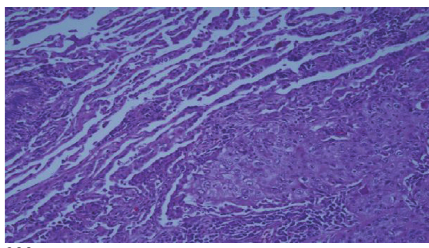
Figure 5: Normal lung tissue with intact alveolar spaces adjacent to the keratinizing squamous cell carcinoma, which, here, is more moderately differentiated and more clearly characteristic of SCC [2]. The tumor measures 4.5 × 3.7 × 2.2 cm, and the distal border of the tumor invades the pleura.